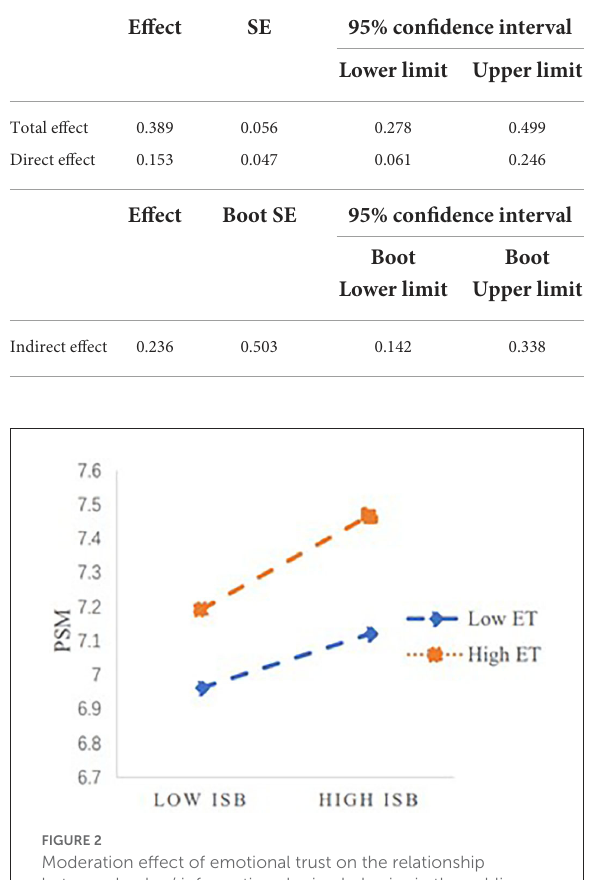
TABLE 5 Mediation effect of PSM under different levels of